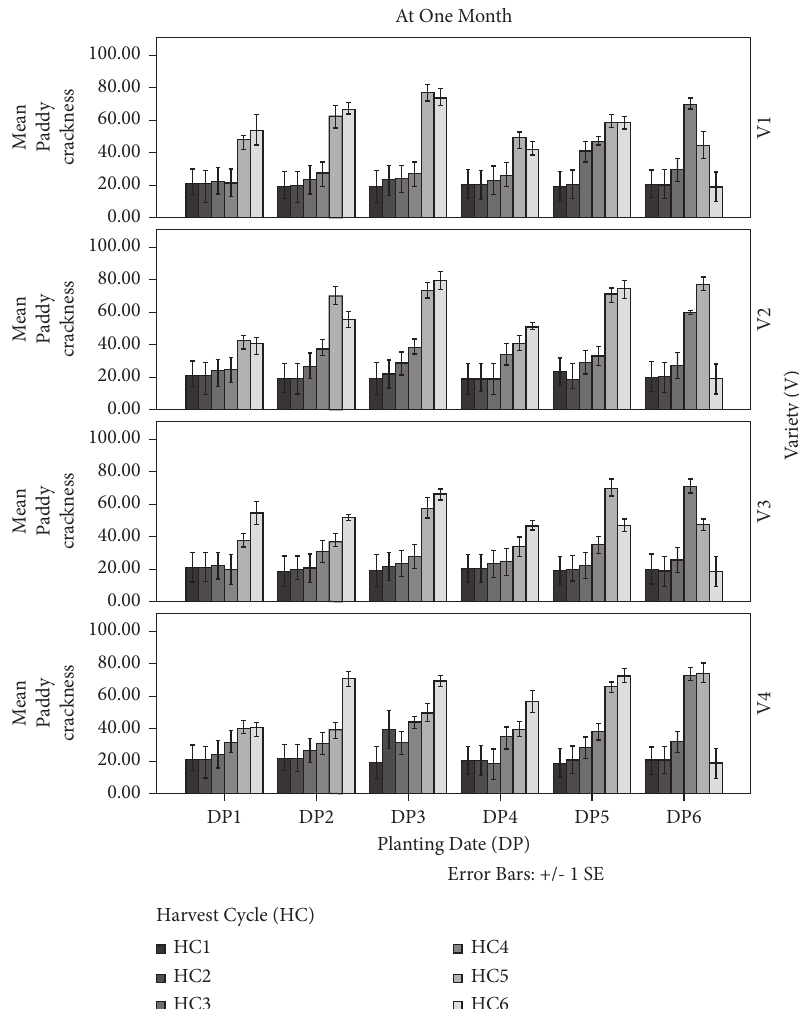
Figure 5: Effect of planting date, variety, and harvest cycle on paddy crackness at one month of storage in the Northern Savanna Agroecological Zone of Ghana. Bars represent the SEM. DP1 � first planting, DP2 � second planting, DP3 � third planting, DP4 � fourth planting, DP5 � fifth planting, DP6 � sixth planting, V1 � Agra, V2 � Gbewaa, V3 � Exbaika, V4 � Perfume Irrigated, HC1 � first harvest, HC2 � second harvest, HC3 � third harvest, HC4 � fourth harvest, HC5 � fifth harvest, and HC6 � sixth